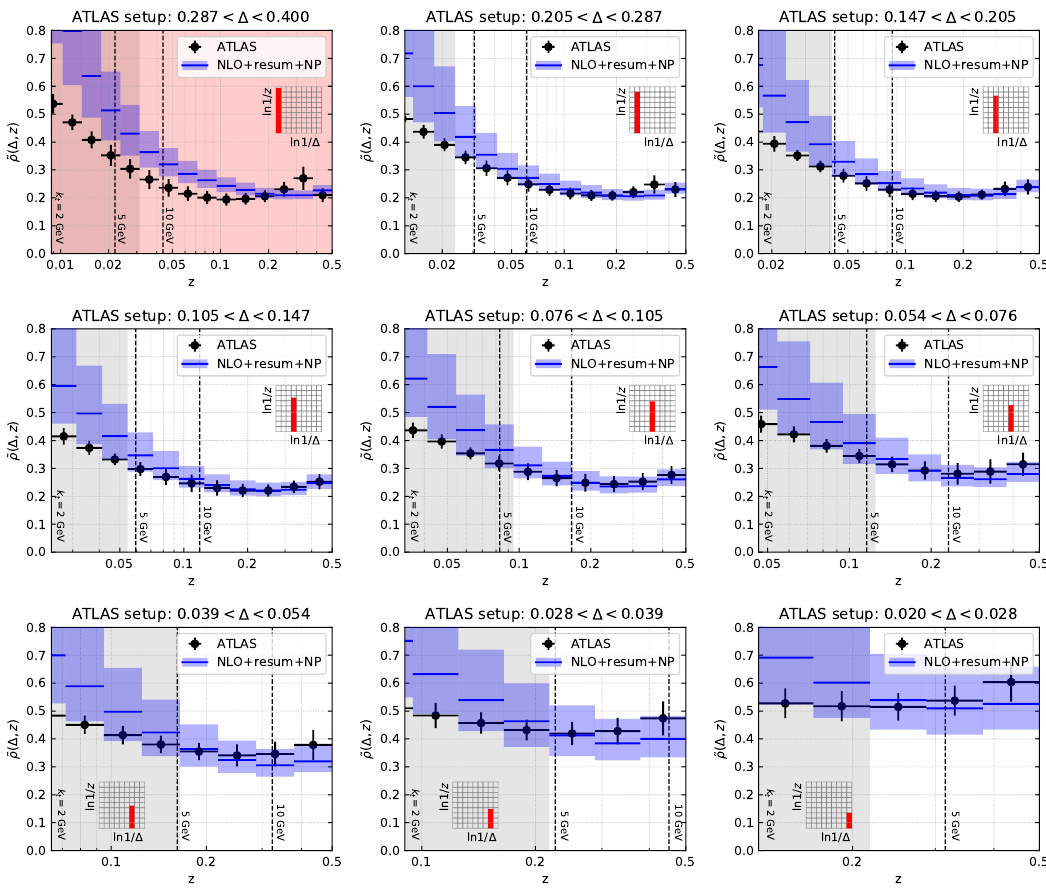
Figure 12. Comparison between our calculations and the ATLAS measurement from ref. [84], for di(cid:11)erent bins of (cid:1). The dashed vertical lines, corresponding to z = k t and several k t values, are meant to indicate the transverse scales one is typically sensitive to. The shaded grey bands indicate bins where the relative uncertainty on the non-perturbative corrections is larger than 10%. The shaded red regions indicate that our calculation is incomplete because of the missing resummation of the boundary logarithms.